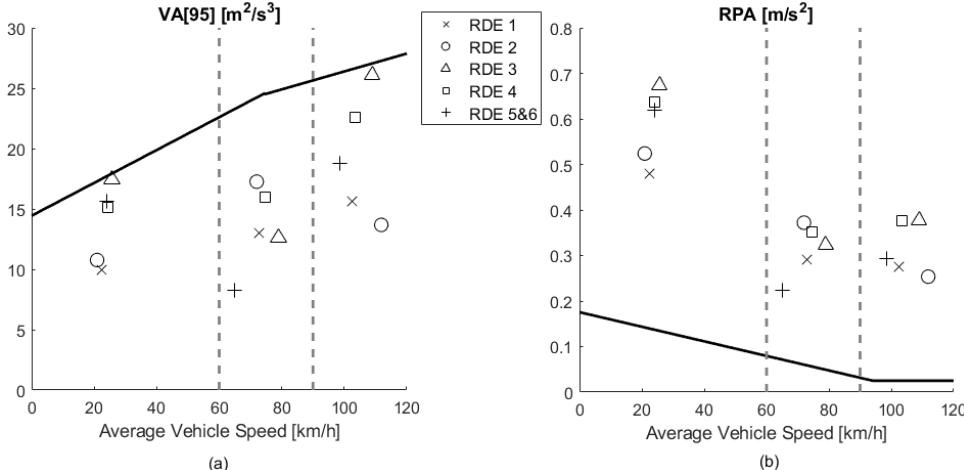
Figure 3. ( a ) VA [95] and ( b ) RPA values in each driving zone for the proposed RDE cycle.